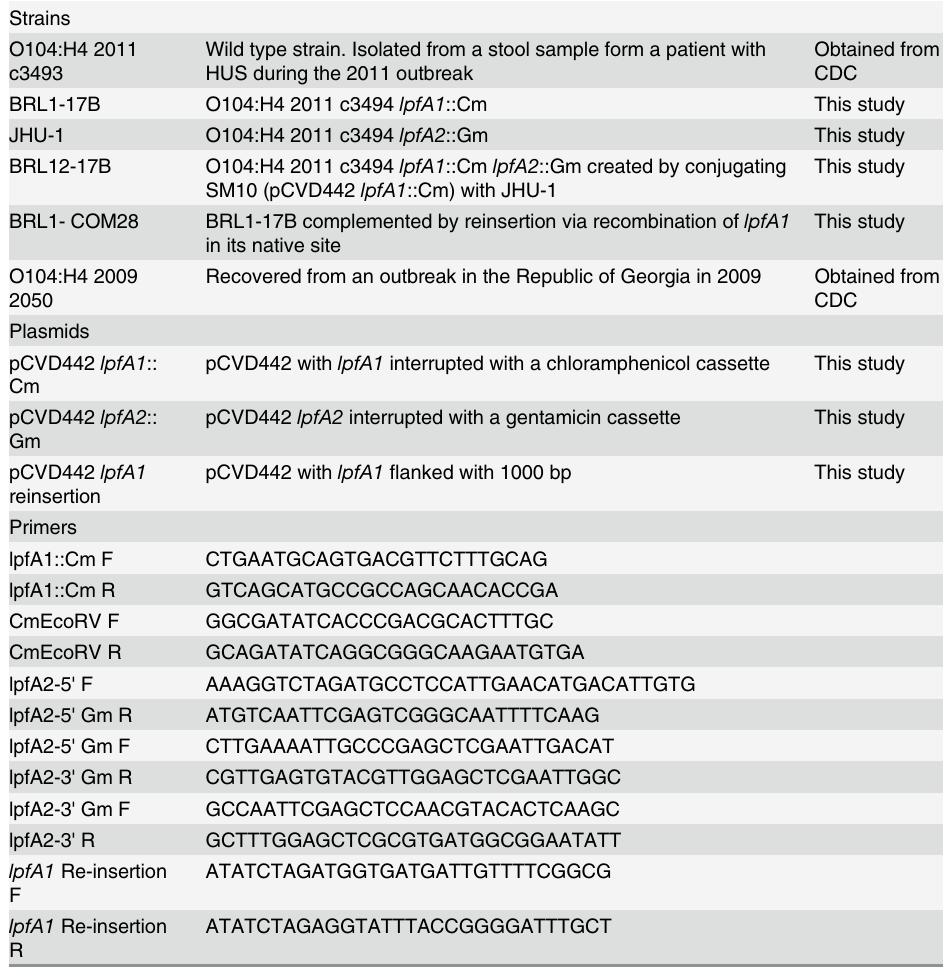
Table 1. Bacterial strains, plasmids and primers used in this study. Strains O104:H4 2011 Wild type strain. Isolated from a stool sample form a patient with c3493 HUS during the 2011 outbreak